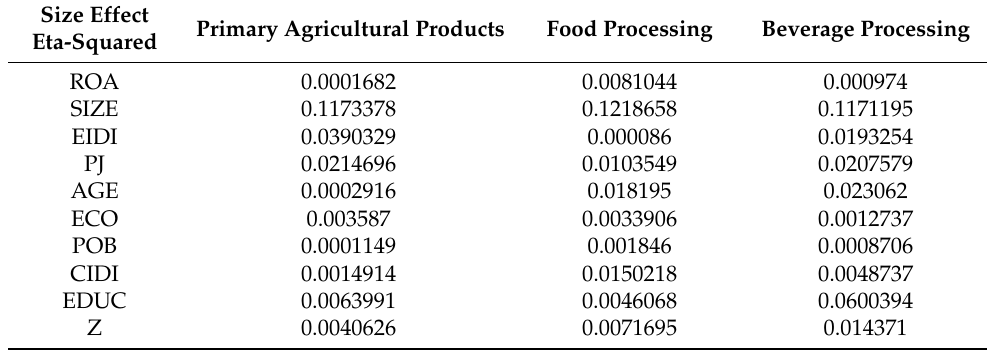
Table 8. Size Effect